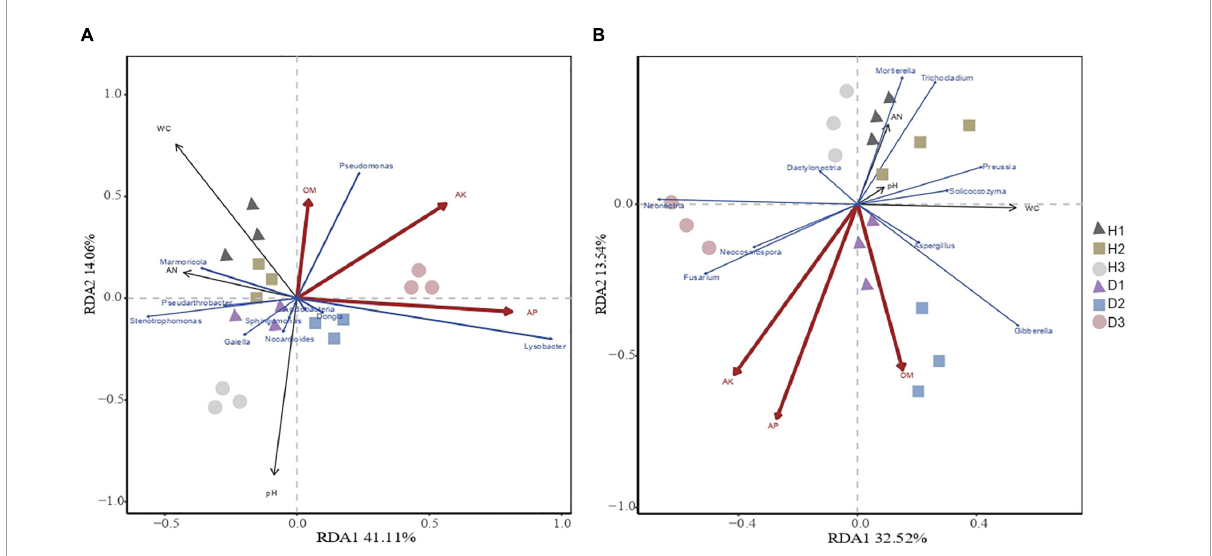
FIGURE3 Redundancy analysis of abundant bacterial (A) and fungal (B) genus and soil properties for healthy and diseased samples from three sampling areas. The“H1,” “H2,” and “H3” refer to the three healthy soils. The “D1,” “D2,” and “D3” refer to the three diseased soils,